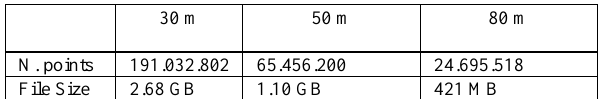
Table 3. N. points and dimension of the dense point cloud